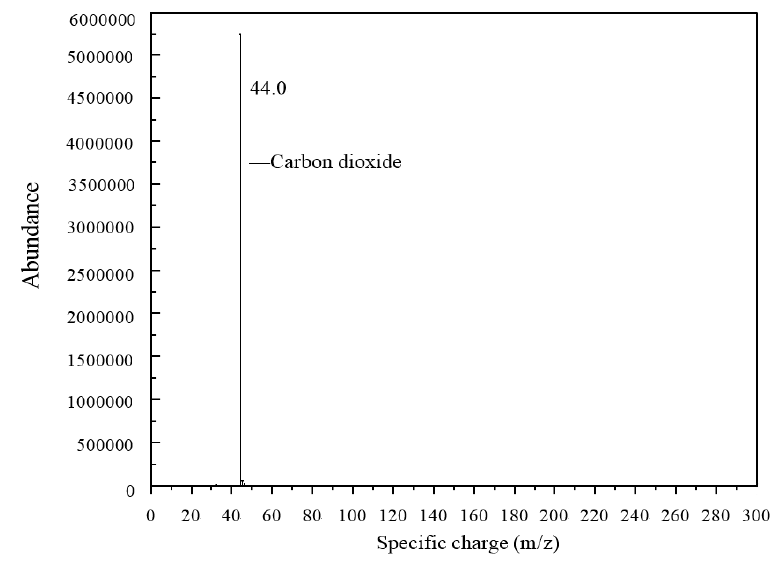
Figure 20. Mass spectrometry of 3% GO-modified asphalt heated to 115 °C.